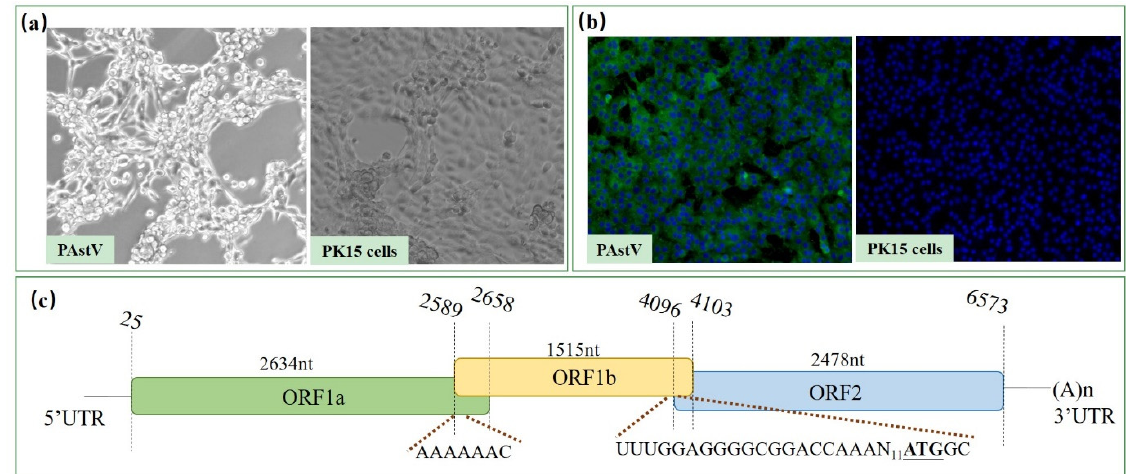
Figure 1. Identification and genomic structure of PAstV/SH/2022/CM1. ( a ) Cytopathic effect of the PAstV/SH/2022/CM1 isolate. The virus was inoculated in PK15 cells and cells appeared shriveled and shed at 60 hour (h) after infection. ( b ) Indirect immunofluorescence assay was carried out 48 h post-infection using the monoclonal antibody against PAstV, which indicated that specific green fluorescence could be detected in the cytoplasm. ( c ) Genomic organization, with three open reading frames: ORF1a, ORF1b, and ORF2.